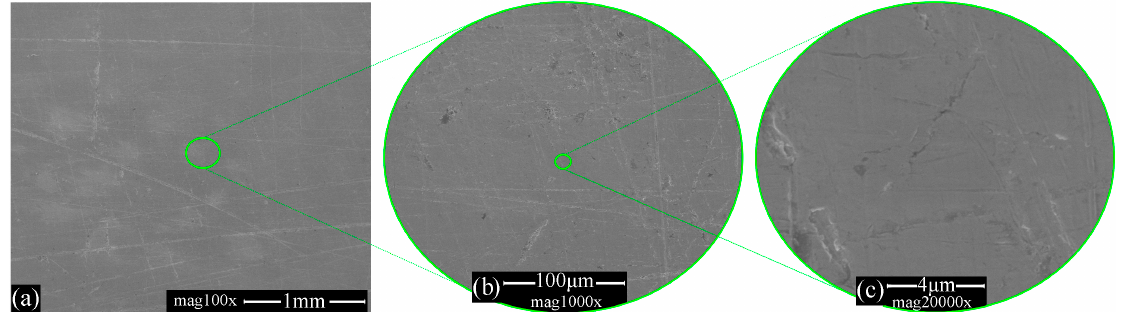
Figure 2. SEM images of mild steel prior exposure to electrolytes ( Steel–blank ). Appl. Sci. 2019 , 9 , x FOR PEER REVIEW